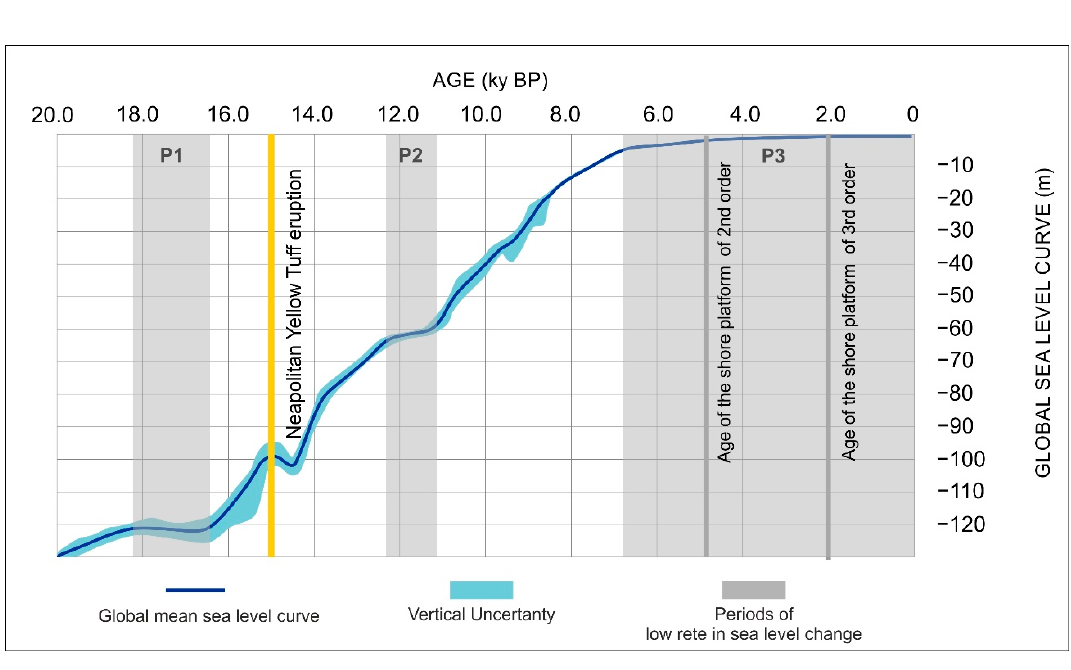
Figure 11. Global eustatic sea-level curve in the last glacial-interglacial circle, after Benjamin et al. [12].